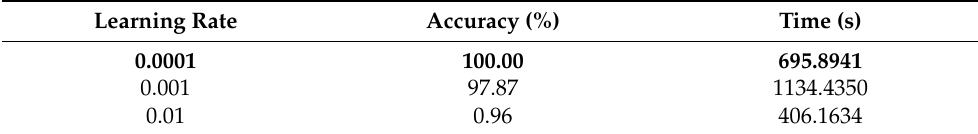
Table 6. Accuracy at different learning rates L [ B = 32, P = 0.3, θ = Adam].